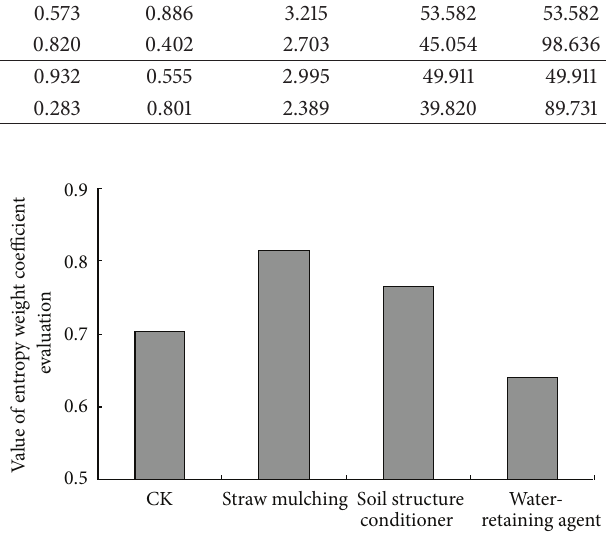
Figure 5: Value of entropy weight coefficient evaluation with different regulatory